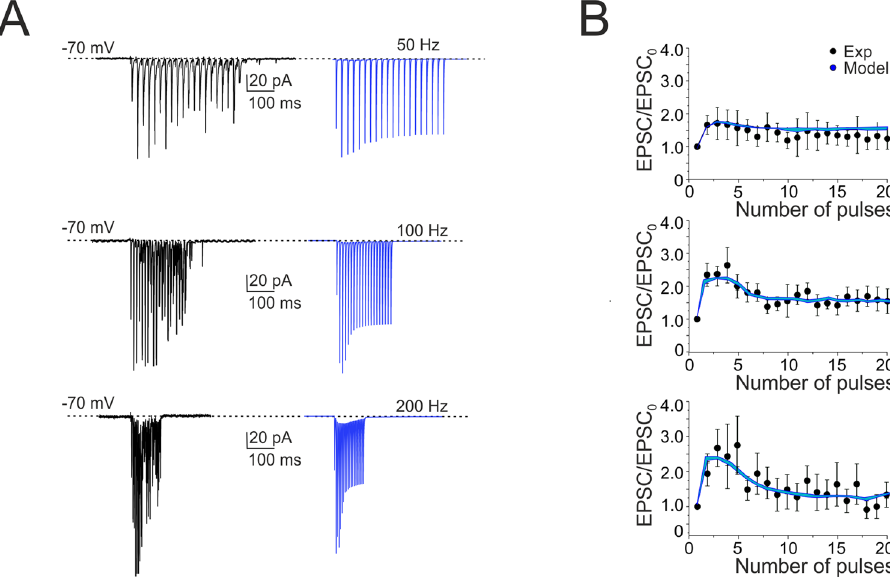
Figure 4. Short-term plasticity at PF-SC synapses. (A) EPSCs recorded from the SC during 50, 100 and 200 Hz parallel fiber stimulations (n = 6). Cells were voltage-clamped at − 70 mV and in the presence of gabazine. Each trace (black) is an average of 10 sweeps. Note that EPSC trains showed first facilitation and then depression. Simulations show that the model could faithfully reproduce the same behavior (blue traces; n = 4). (B) Comparison of peak amplitudes of experimental and simulated EPSCs during high-frequency parallel fiber stimulation. Amplitudes are normalized to the first EPSC in the train (correlation coefficient R 2 @ 50 Hz = 0.80; @ 100 Hz = 0.90; @ 200 Hz = 0.84). Data are reported as mean ±